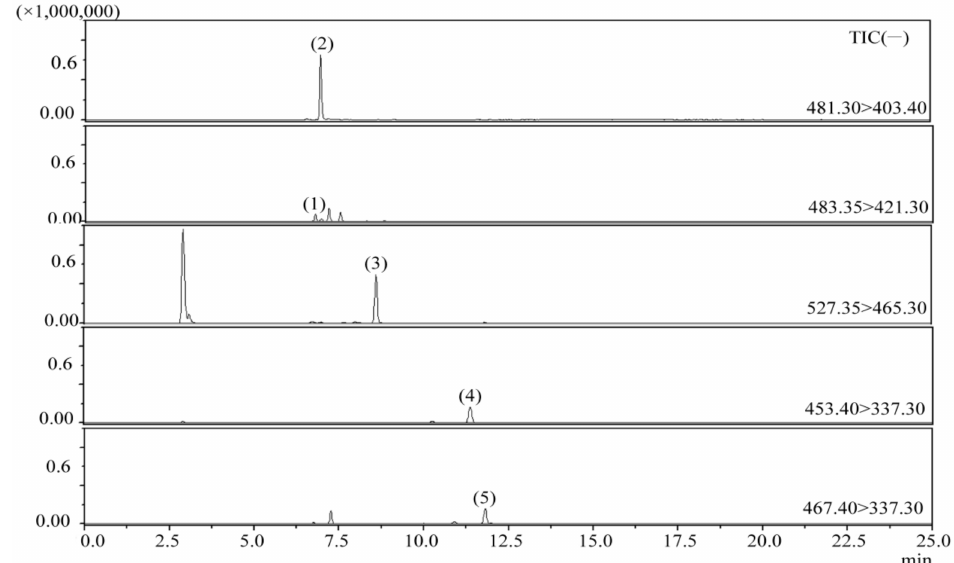
Figure 2. Chromatographic profile of representative samples from multiple reaction monitoring (MRM) method, ions extracted from full scan chromatogram: (1) dehydrotumulosic acid; (2) polyporenic acid C; (3) pachymic acid; (4) dehydrotrametenolic acid; (5) dehydroeburicoic